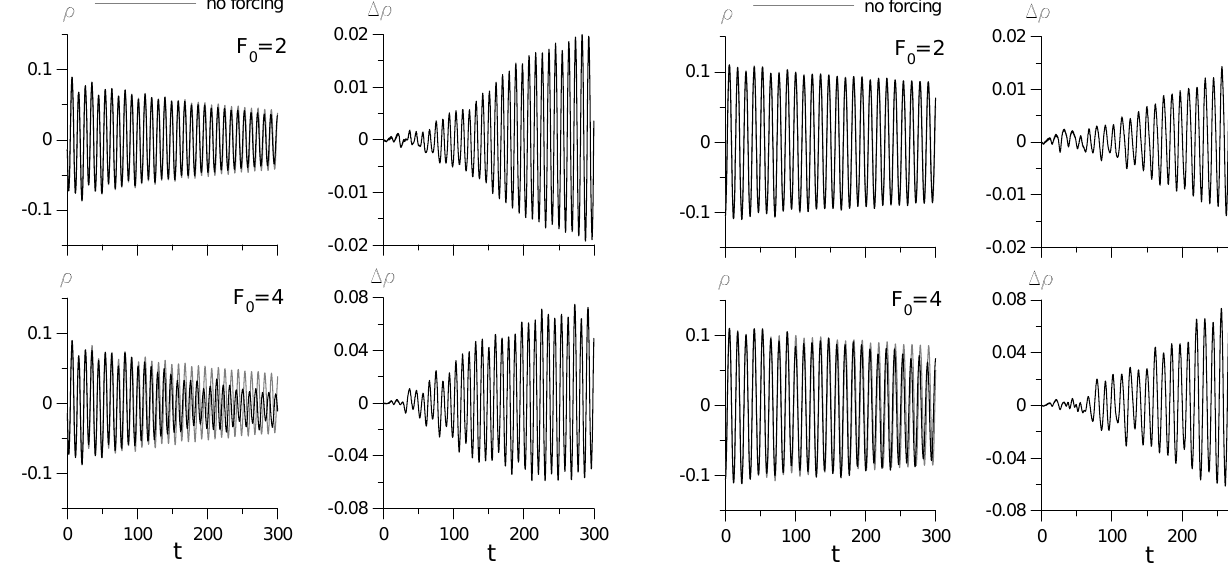
Fig. 8b. The same as in Fig. 8a but for IW wavelength λ = 8. (right f ρρ−